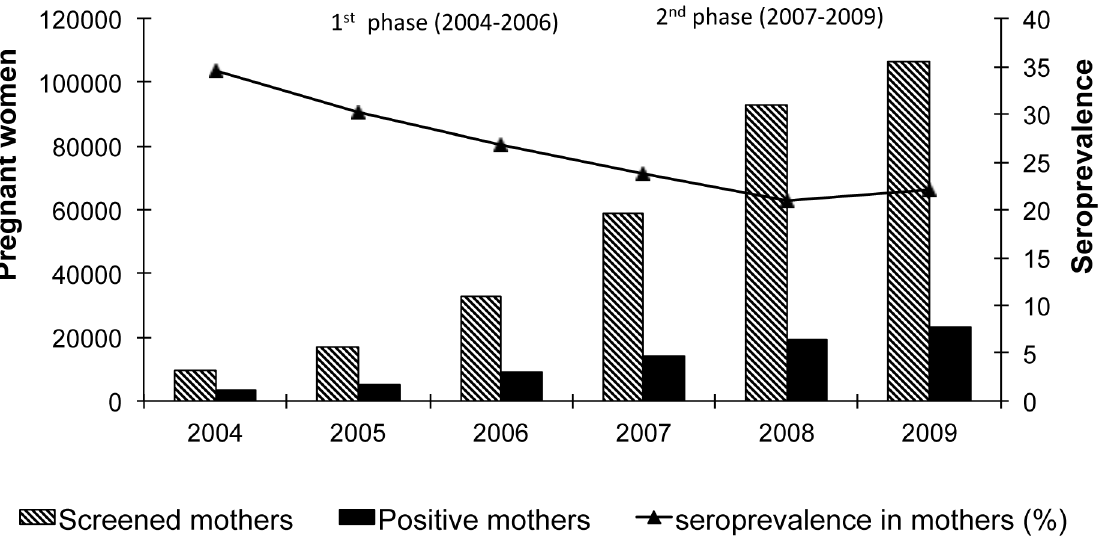
Figure 2. Total of pregnant women screened and seroprevalence 2004–2009. The 1 st phase includes the departments of Cochabamba, Tarija, and Chuquisaca, with a large seroprevalence in Chagas disease. The 2 nd phase additionally includes the departments of Santa Cruz, La Paz and Potosi, with a lower seroprevalence. The average prevalence decreases as the total of women screened increases in less endemic areas.